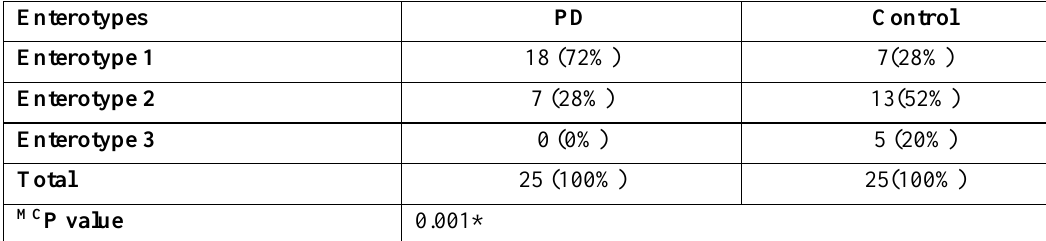
Table 3. Comparison between the two study groups according to the Enterotypes.